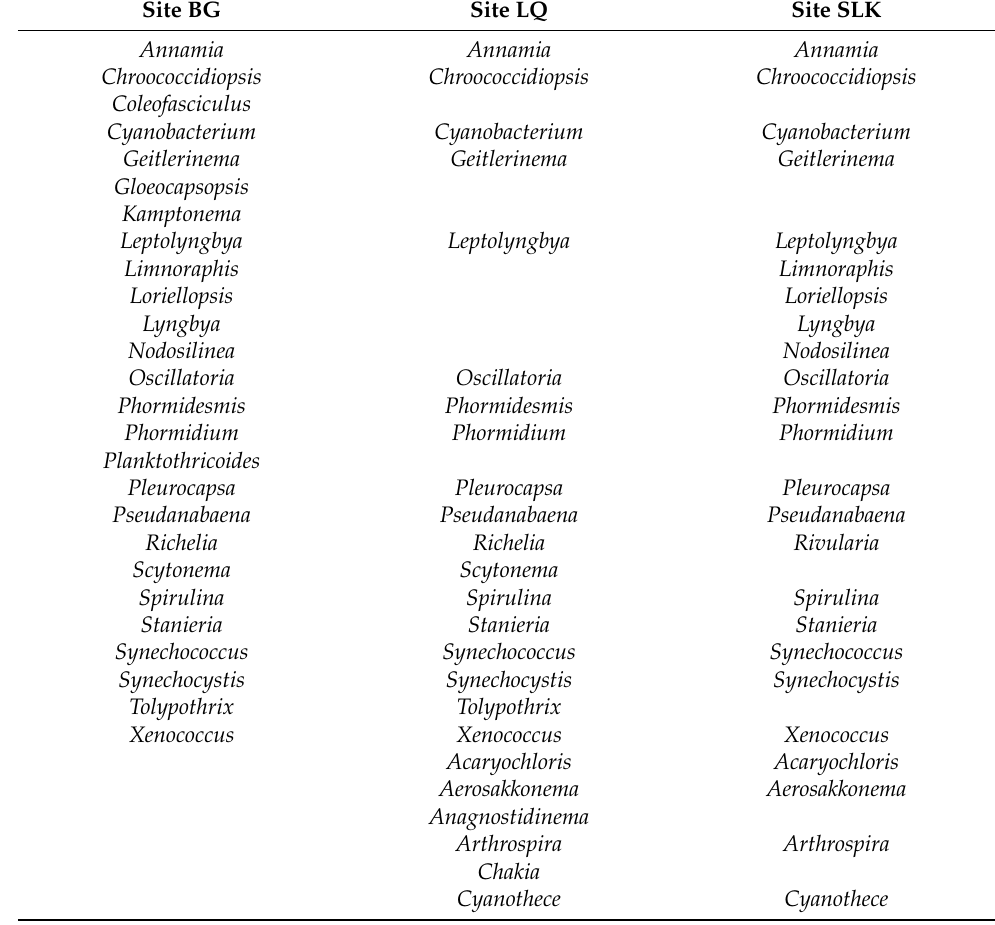
Table 3. Cyanobacterial genera detected at the three different sites of Weizhou